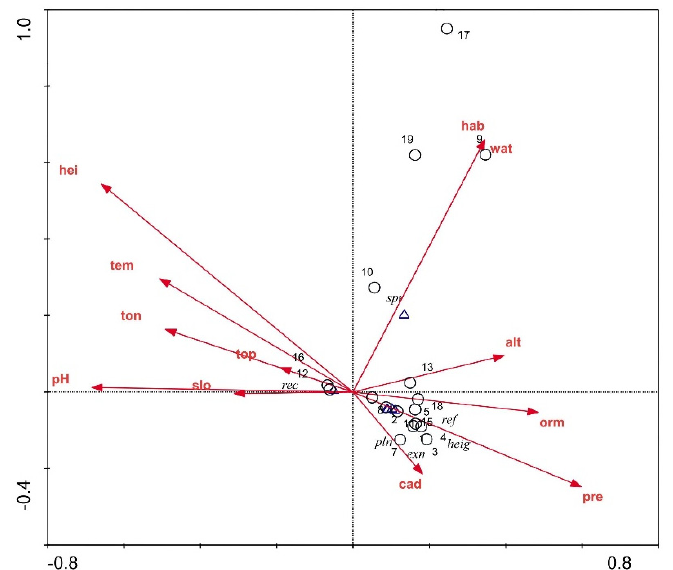
Figure 6. CCA ordination diagram of P. criopolitanum . Note: alt:altitude; hei: height gap; wat: water; hab: habitat; pre: precipitation; tem: temperature; slo: slope; cad: canopy density; pH: pH; orm: organic matter; ton: total nitrogen; top: total phosphorus. Positions of the samples and environmental factors are indicated by open circle ( ) and open triangle ( (cid:52) ), (cid:35)